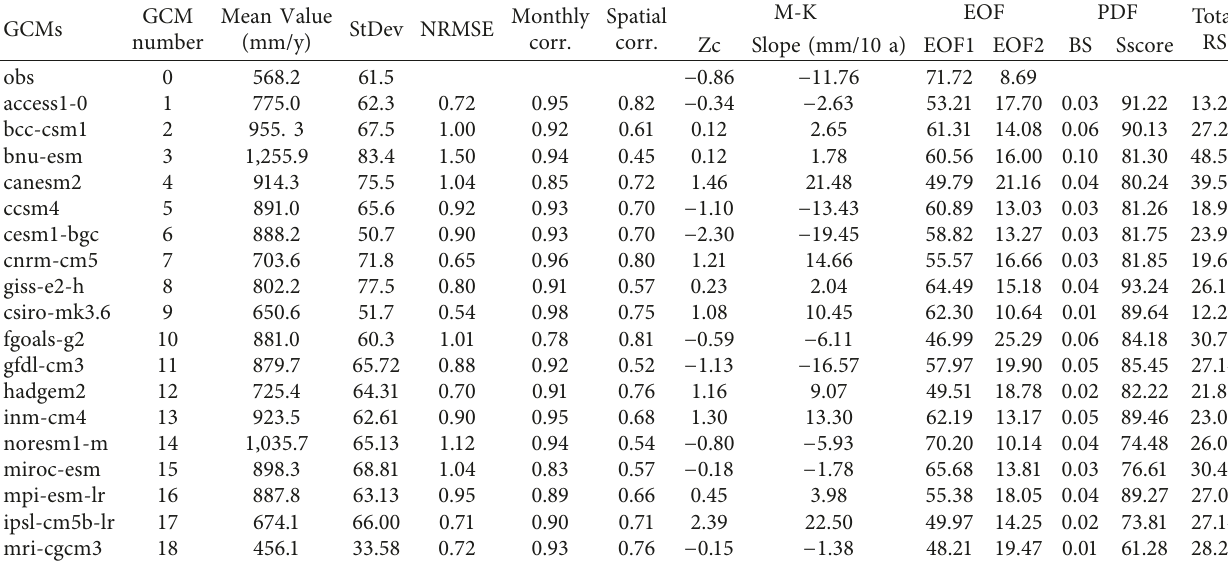
Table 3: Model performances for precipitation.